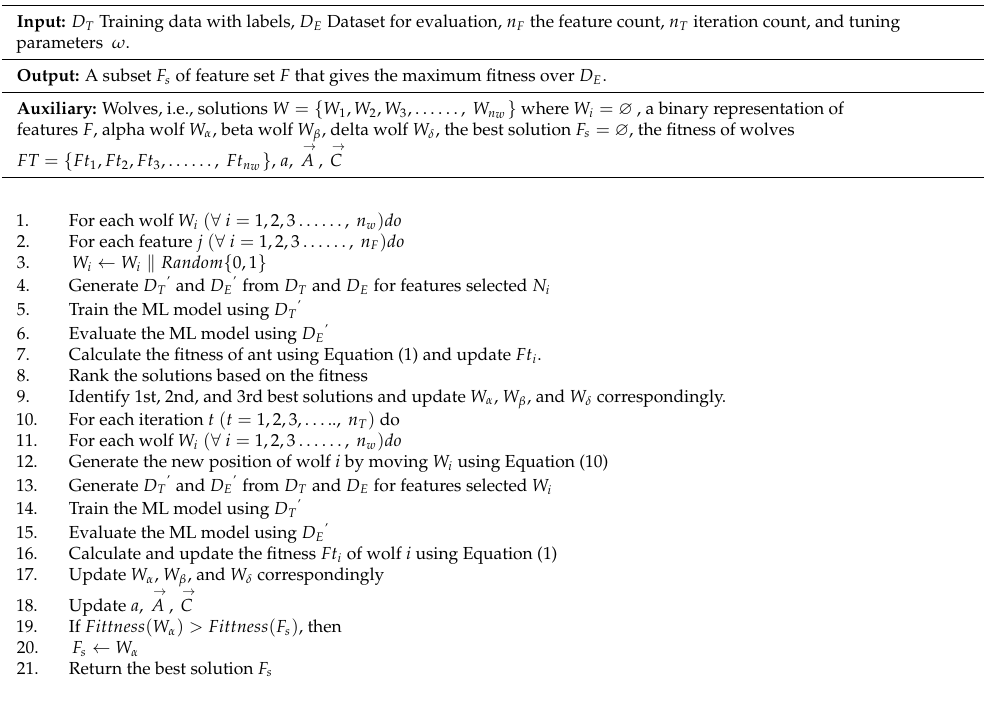
Algorithm 4 . Grey Wolf Optimization Wrapper Feature Selection